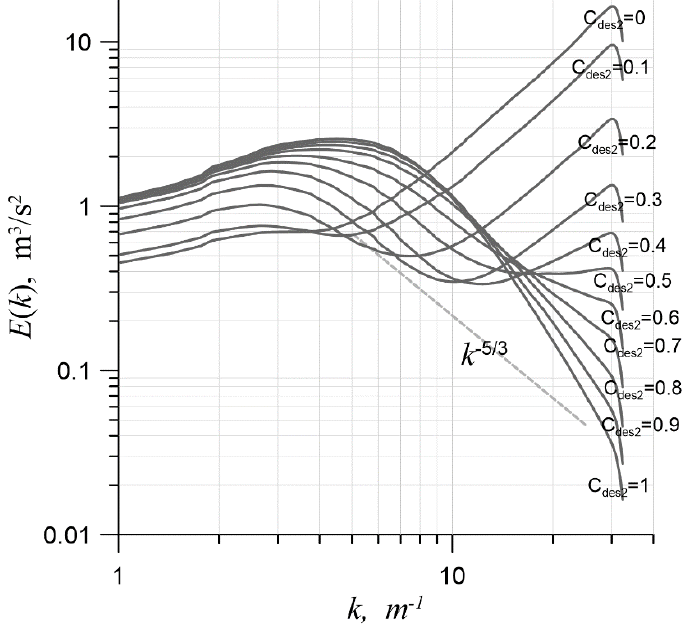
Figure 6. The spectrum on a mesh with 64 3 cells, with different C DES 2 values.